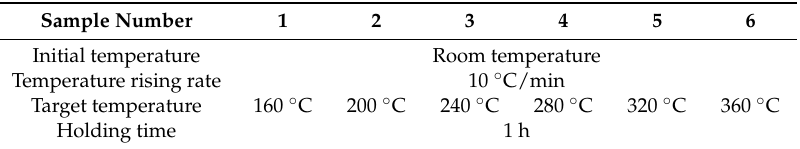
Table 2. Isochronous annealing treatment parameters.